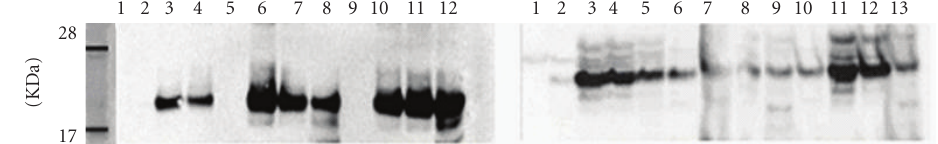
Figure 8: Western blot analysis of the intra- and extracellular of rhIL-7 produced in Sf9 insect cells. (a) Intracellular protein in Sf9: (lanes 1– 3: 24hpi, using MOI 5, 1 and 0.5 of the virus stock, respectively, lanes 4–6 48 hpi. Lanes 7–9: 72hpi and lanes 10–12 96hpi). (b) Extracellular protein in Sf9: (lanes: 2–4 24hpi using MOI 5, 1 and 0.5 virus stock, respectively, lanes: 5–7 48hpi, lanes: 8–10 72 hpi, lanes: 11–13